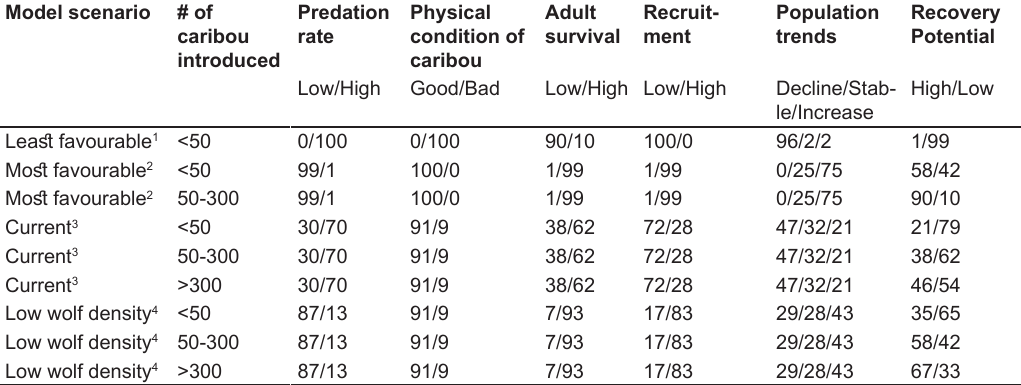
Table 1. Probability of recovery potential (%) under different model scenarios and number of caribou introduced. Percent probability of five child nodes are also presented.